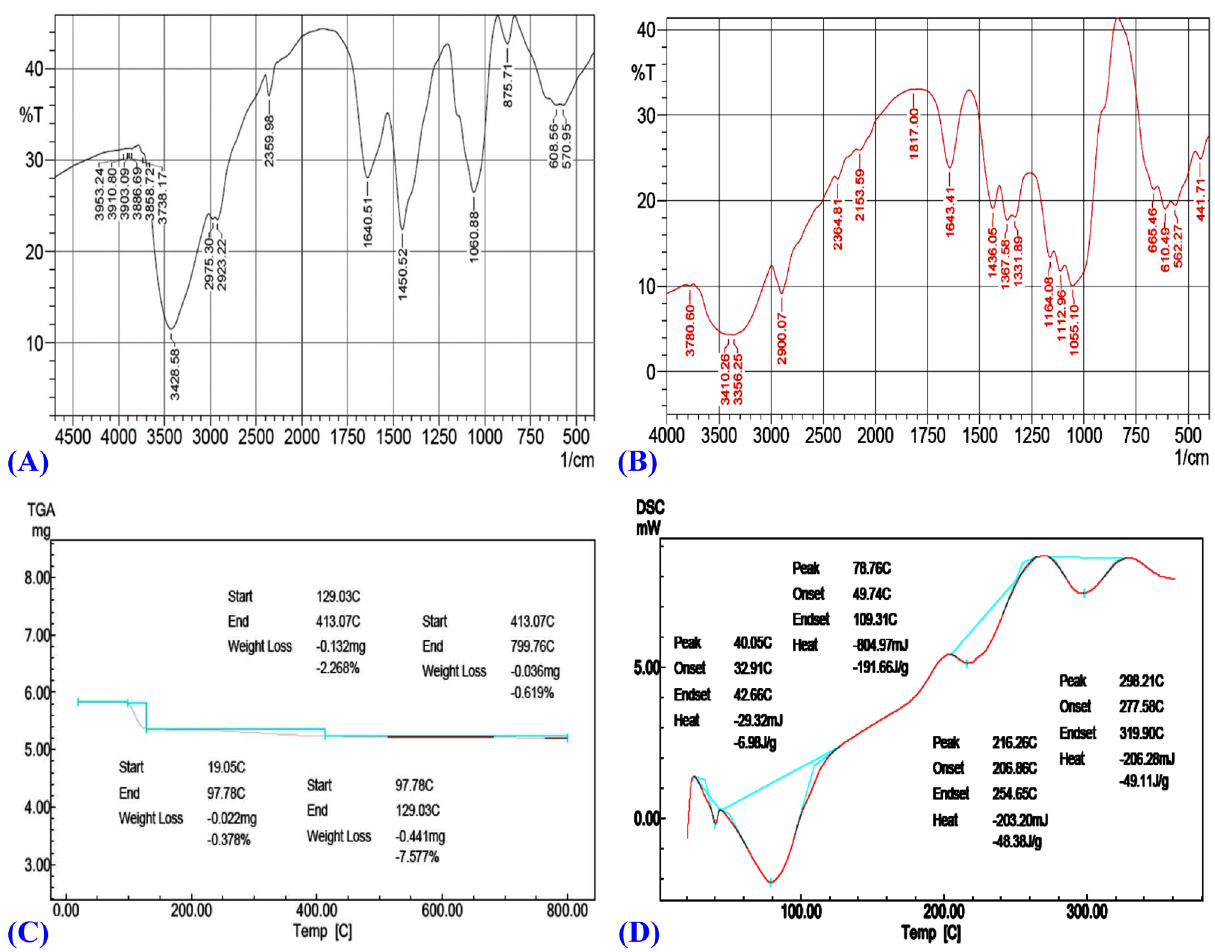
Figure 6. FTIR spectra of: ( A ) Bacillus sp . strain SEE-3 bacterial nanocellulose; and ( B ) Avicel PH101, ( C ) Thermogravimetric analysis (TGA), and ( D ) DSC analysis for Bacillus sp . strain SEE-3 bacterial